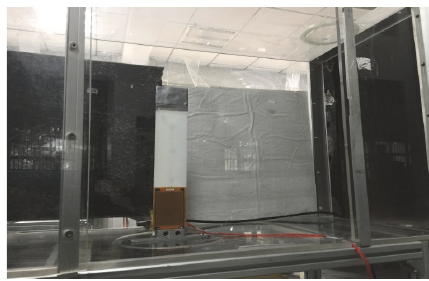
Figure 1: Wind tunnel